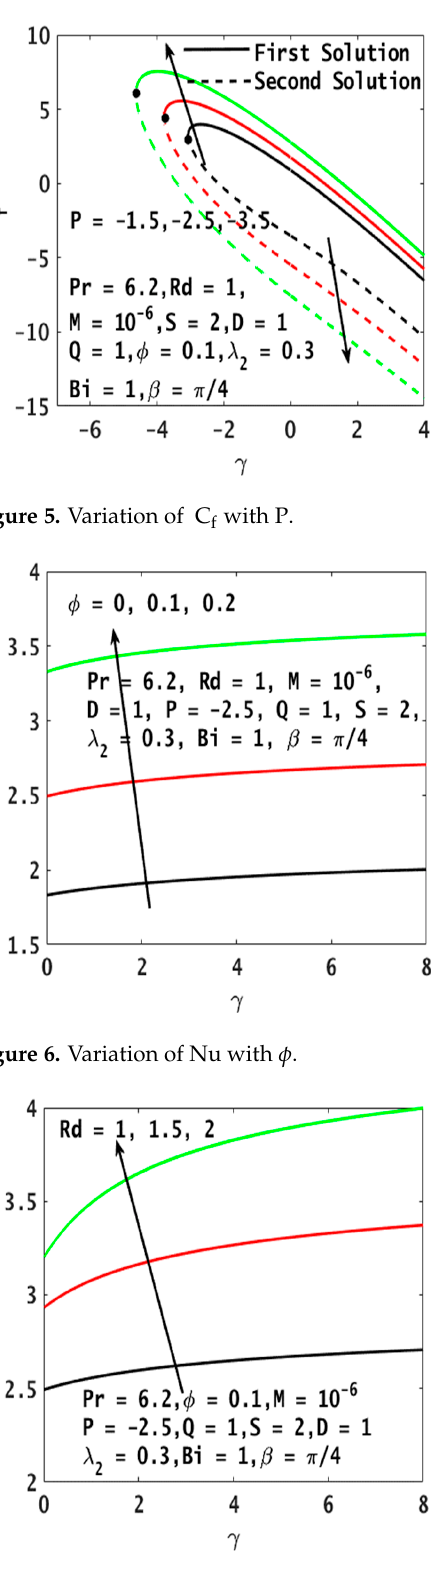
Figure 7. Variation of Nu with Rd.